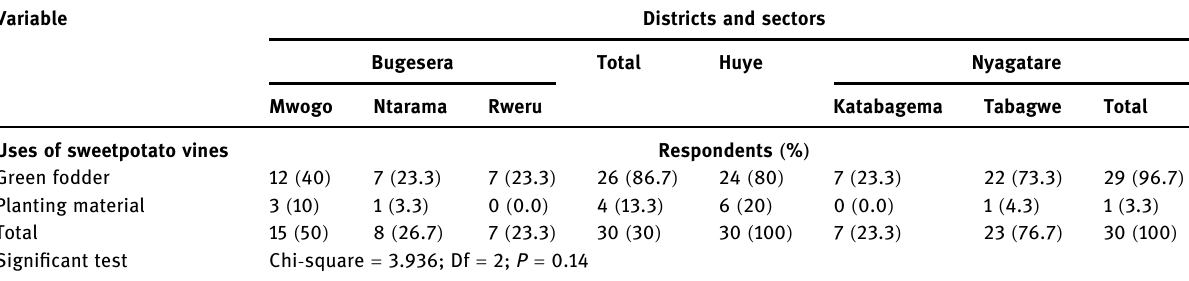
Table 2: Uses of sweetpotato vines across three districts of Rwanda Variable Districts and sectors